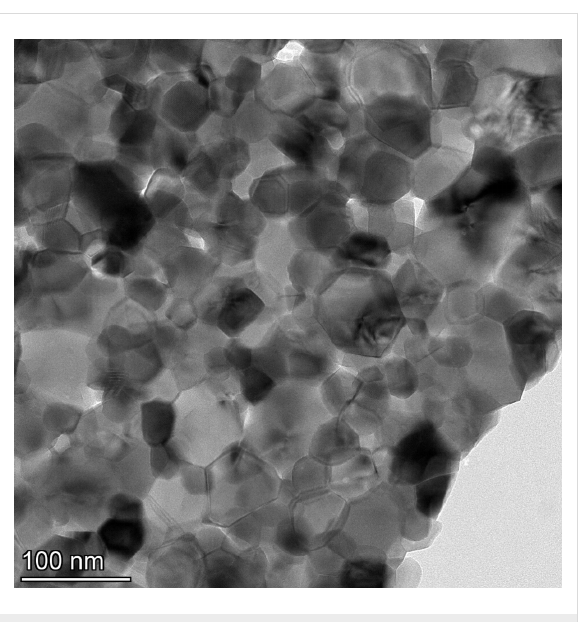
Figure 5: Transmission electron microscopy image of calcined solvothermally synthesized